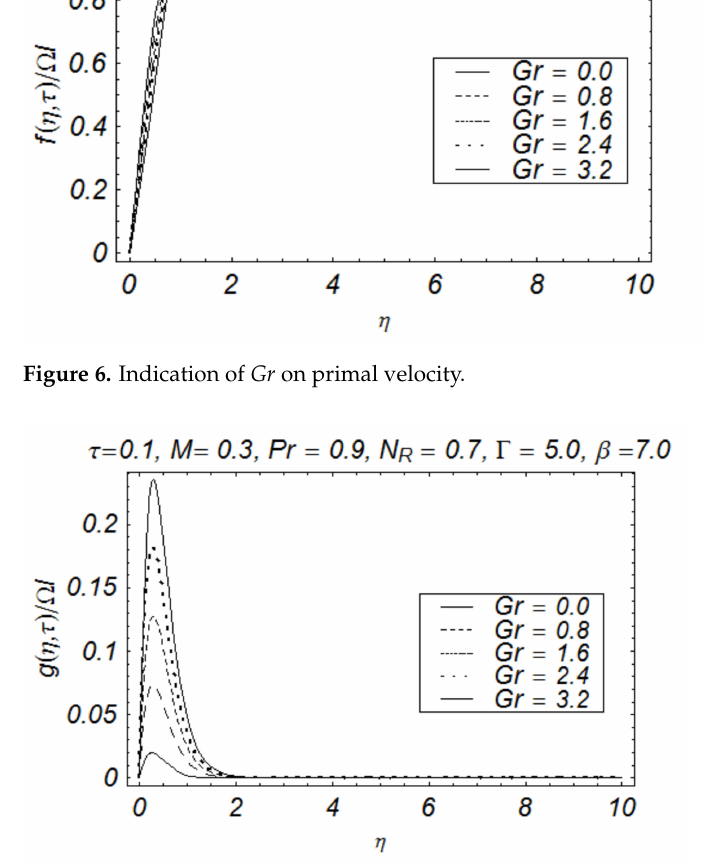
Figure 7. Indication of Gr on secondary velocity.